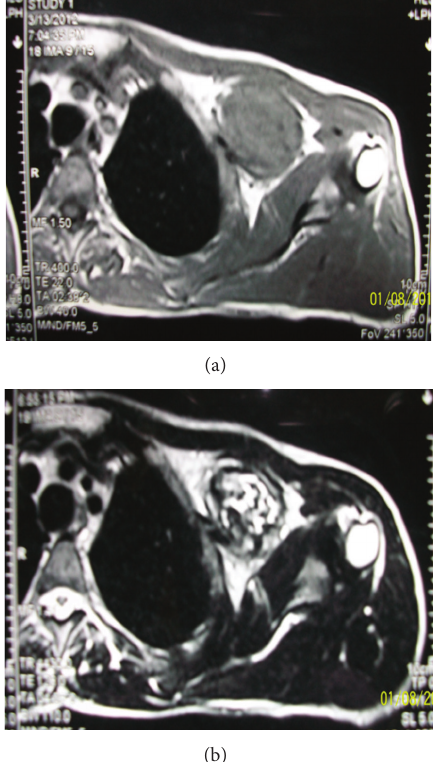
Figure 2: Axial MRI T1W (a) and T2W (b) images showing a well- defined brachial plexus desmoids tumour that was isointense to muscle on T1W sequences and mixed signal intensity (both low to high signal intensity) on T2W sequences and was straddling the brachial